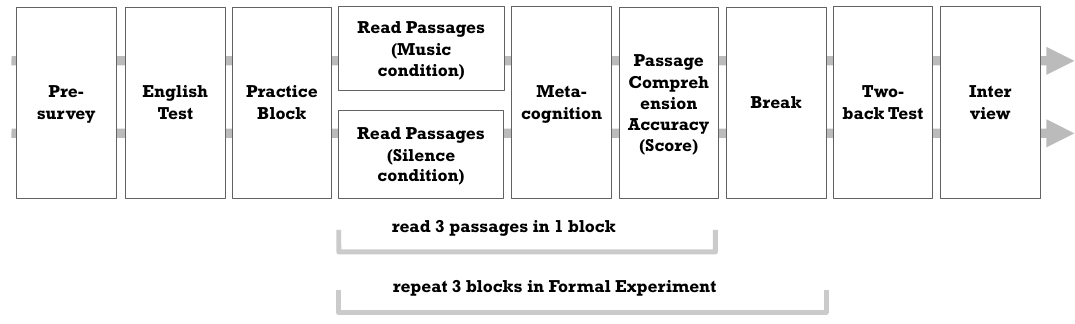
Figure 1. Procedure of the